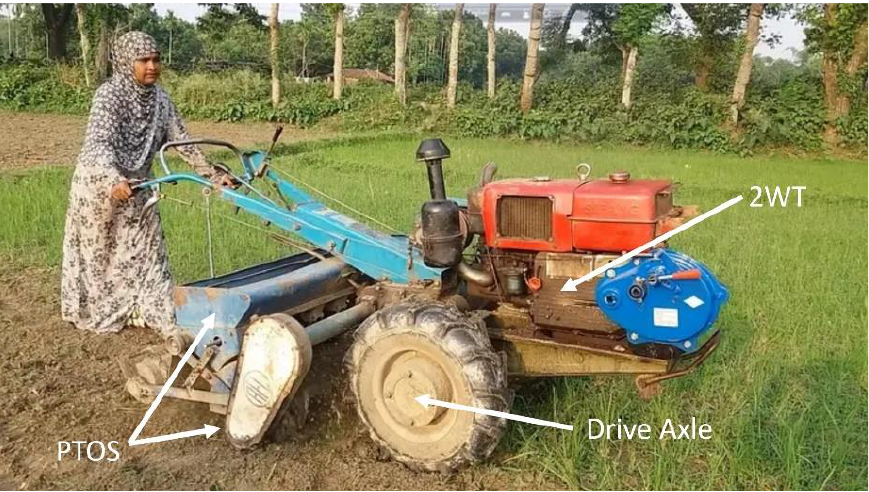
Figure 1. Two-wheel tractor with a PTOS attachment [7].